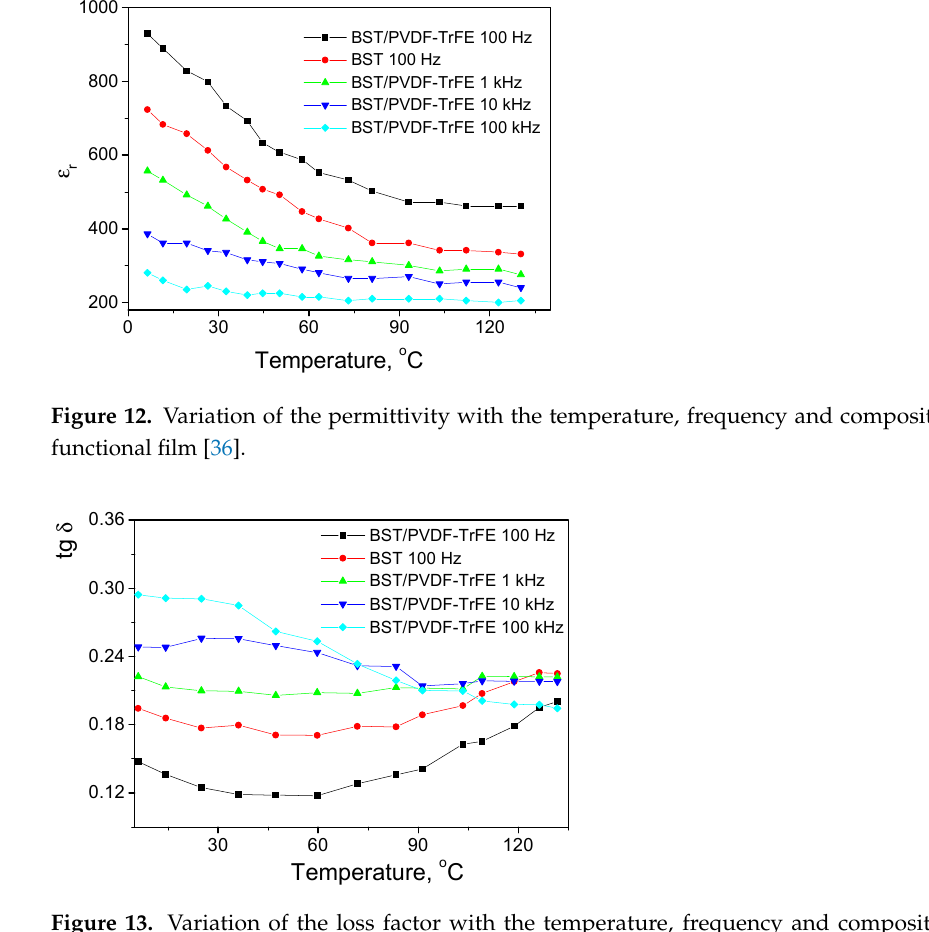
Figure 13. Variation of the loss factor with the temperature, frequency and composition of the functional film [36].